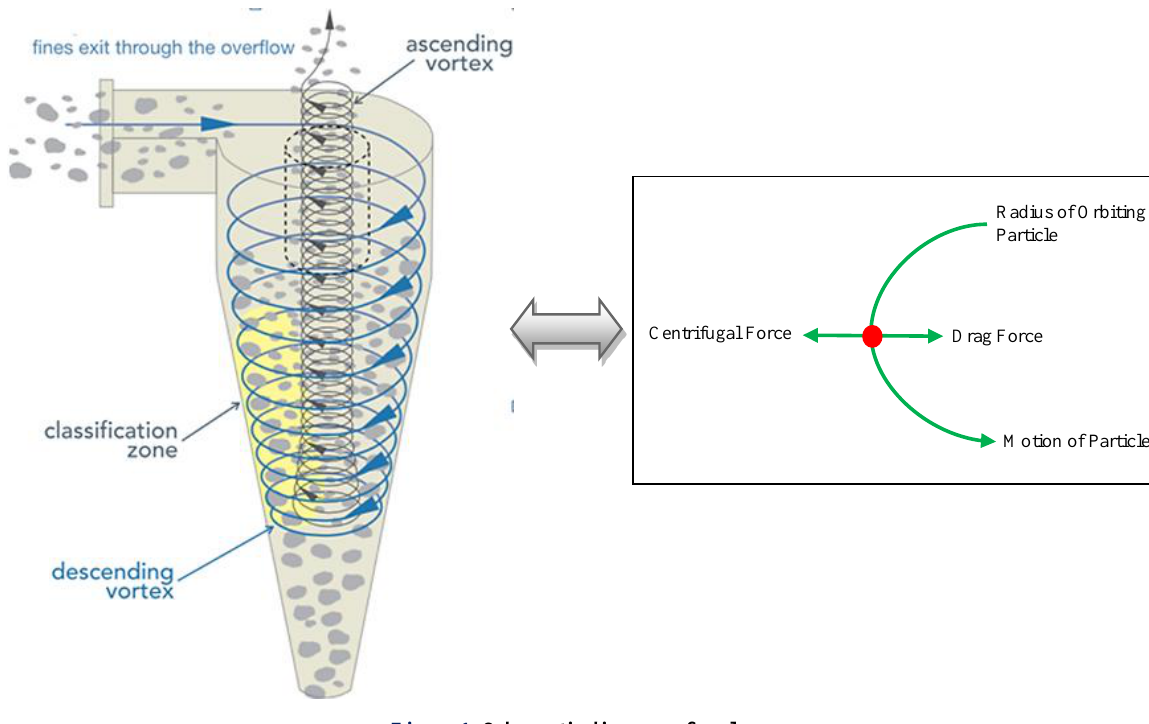
Figure 1. Schematic diagram of